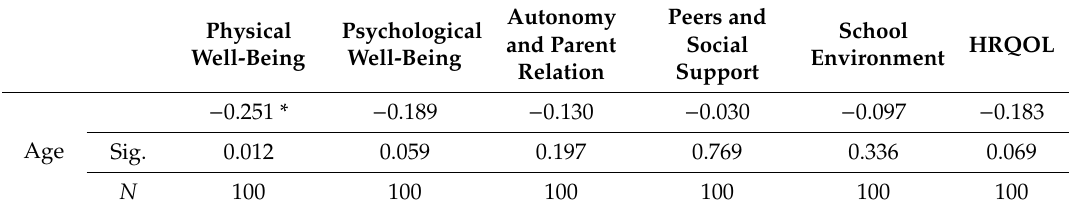
Table 7. Correlations between age and questionnaire scales.